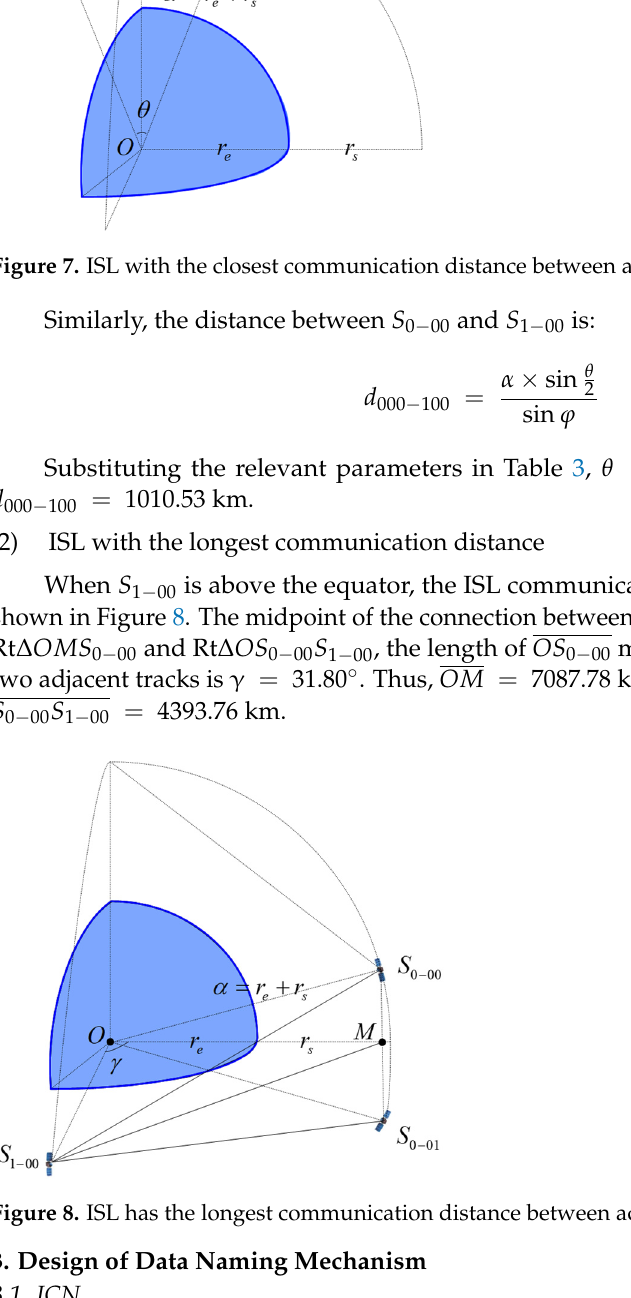
Figure 8. ISL has the longest communication distance between adjacent orbital planes.